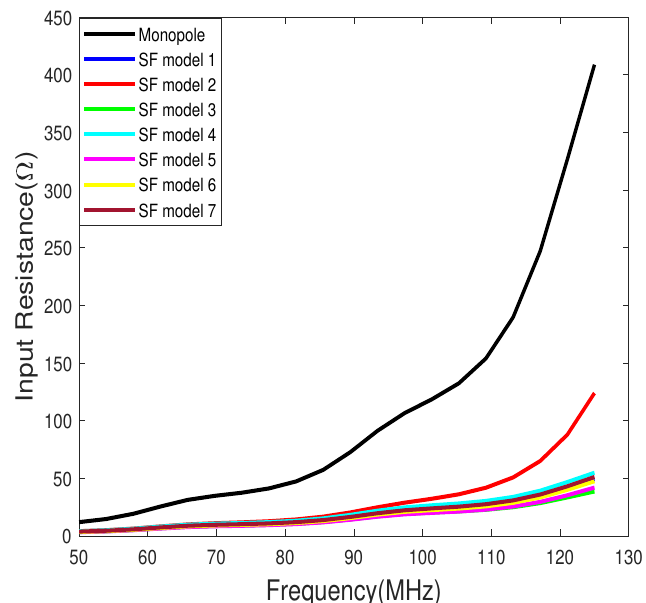
Figure 20. Input resistance of the monopole and the single-fold antenna models from FEKO.